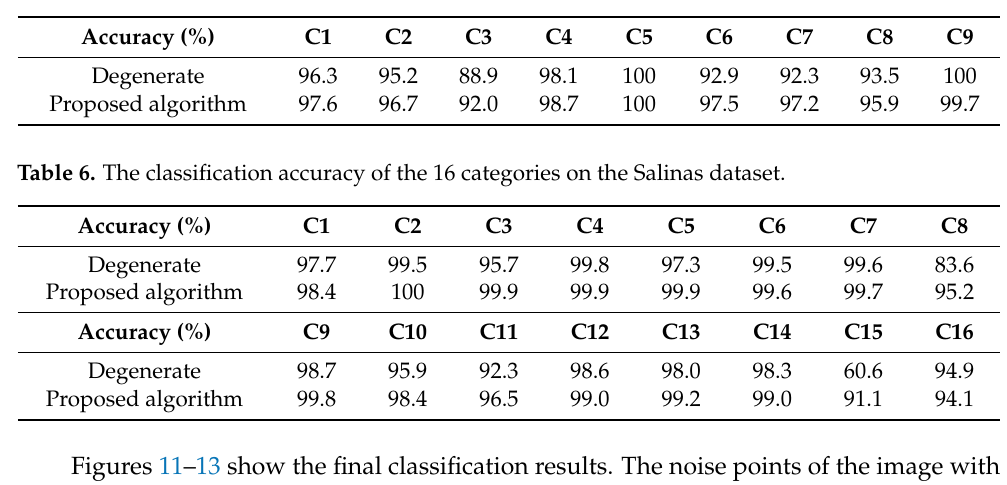
Table 5. The classification accuracy of the 9 categories on the PaviaU dataset.